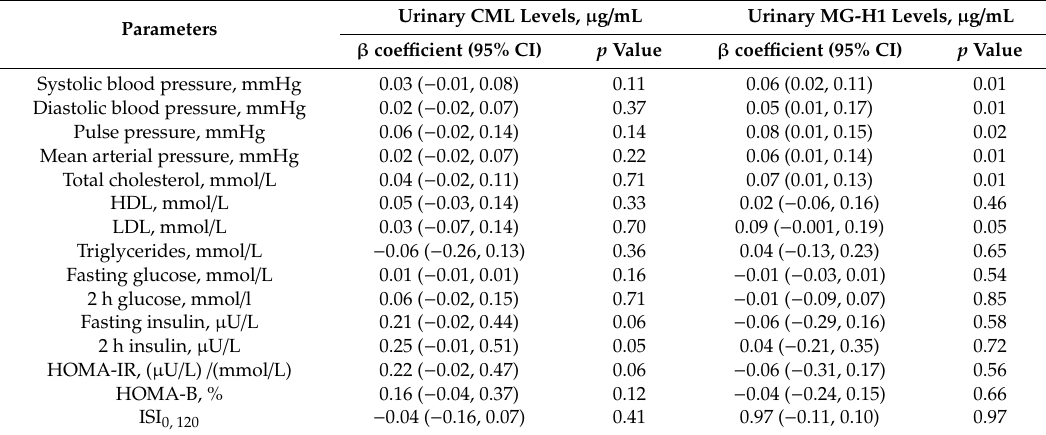
Table 3. Multivariable analyses of urinary AGE levels with cardiometabolic parameters.